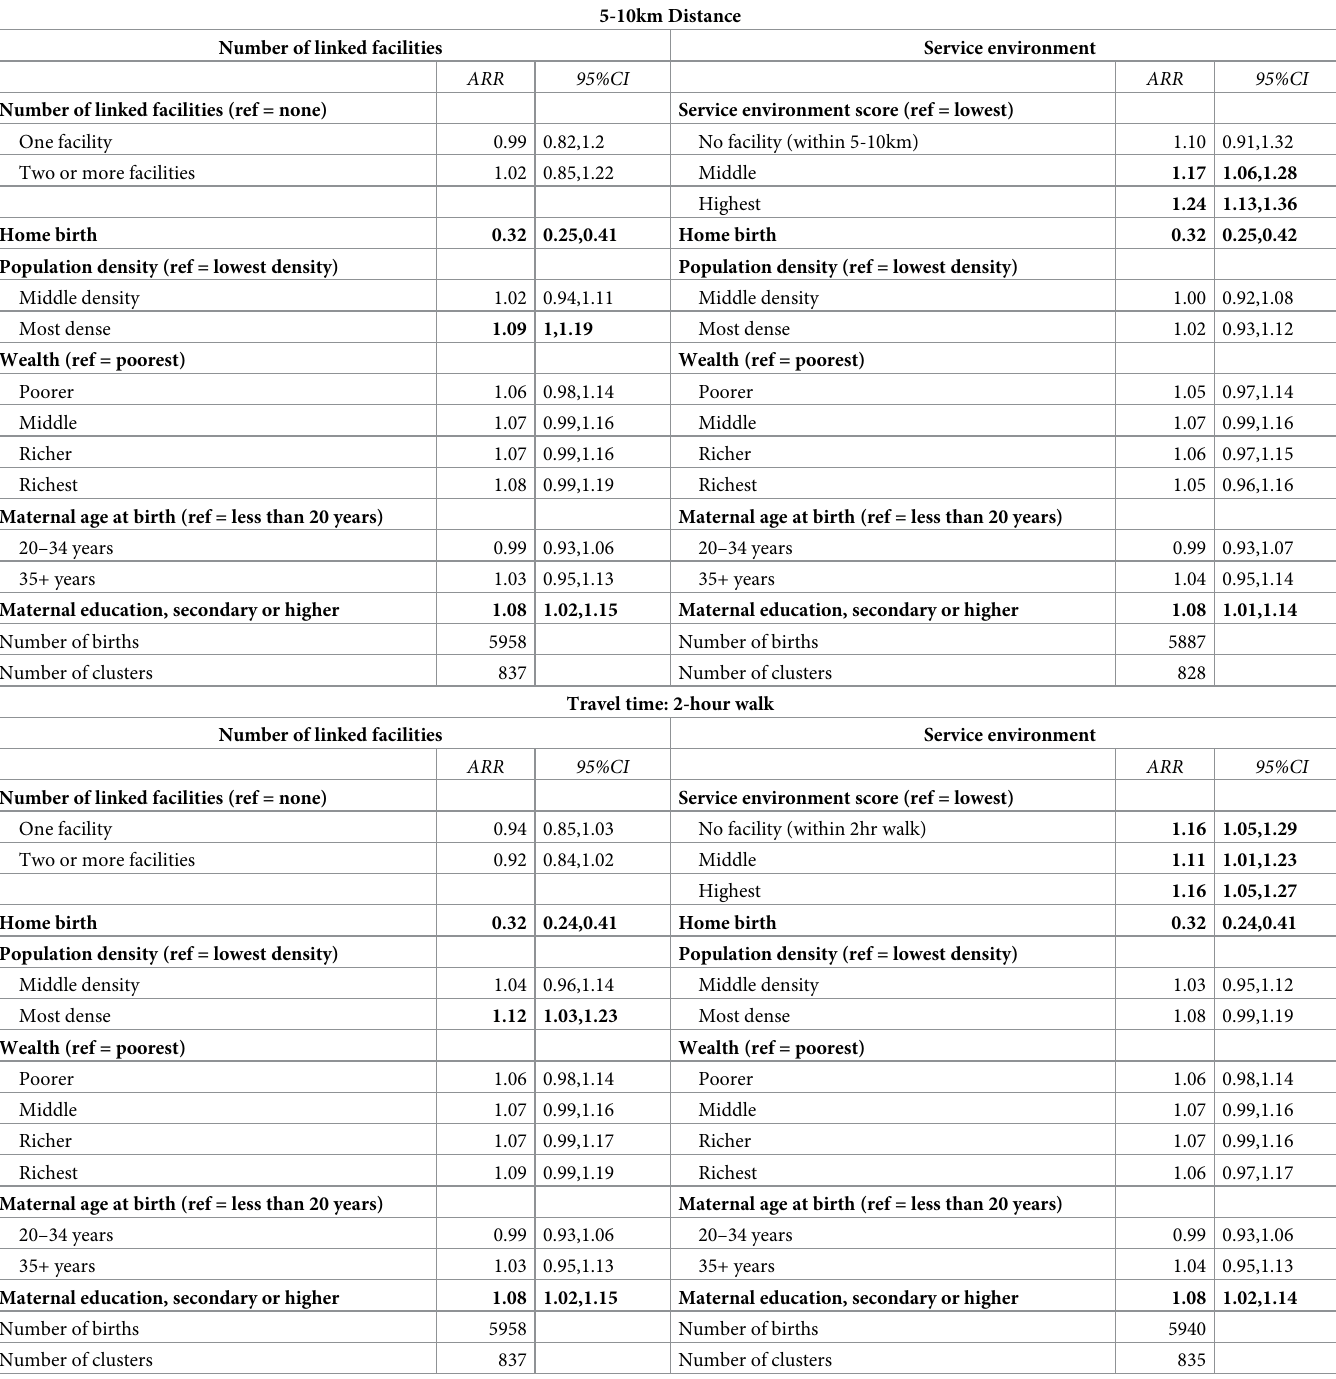
Table 3. Distance linked facility number and service environment association with newborn care